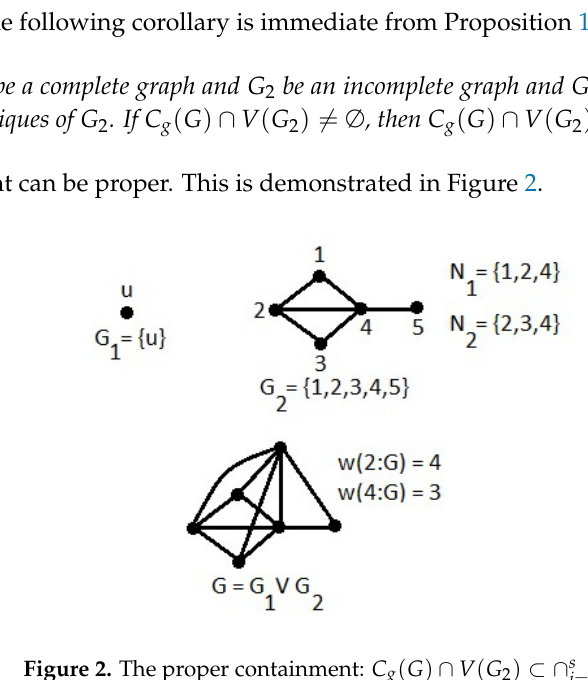
Figure 2. The proper containment: C g ( G ) ∩ V ( G 2 ) ⊂ ∩ s